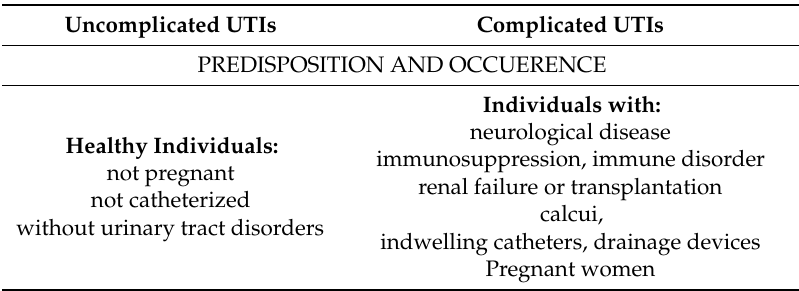
Table 1. Clinical types of urinary tract infections (UTIs) [4,14–18].